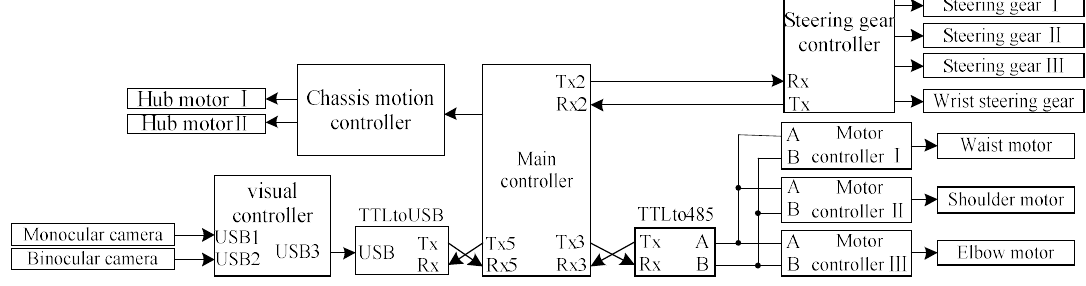
Figure 11. Structure diagram of the control system.